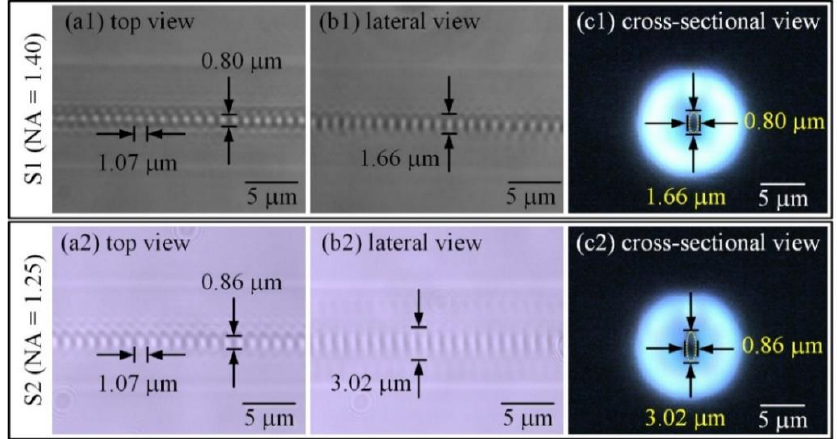
Figure 2. Grating morphologies inscribed with objective NA of 1.40 and 1.25, respectively. ( a ) Top-view, ( b ) side-view and ( c ) cross-sectional-view microscope images of FBGs inscribed with objective NA of 1.40 and 1.25.